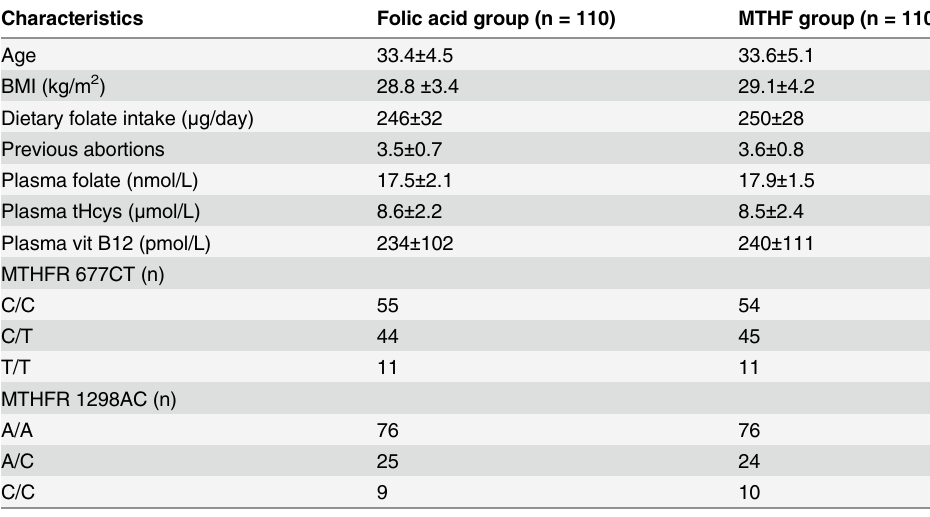
Table 1. Demographic characteristics of the study sample at